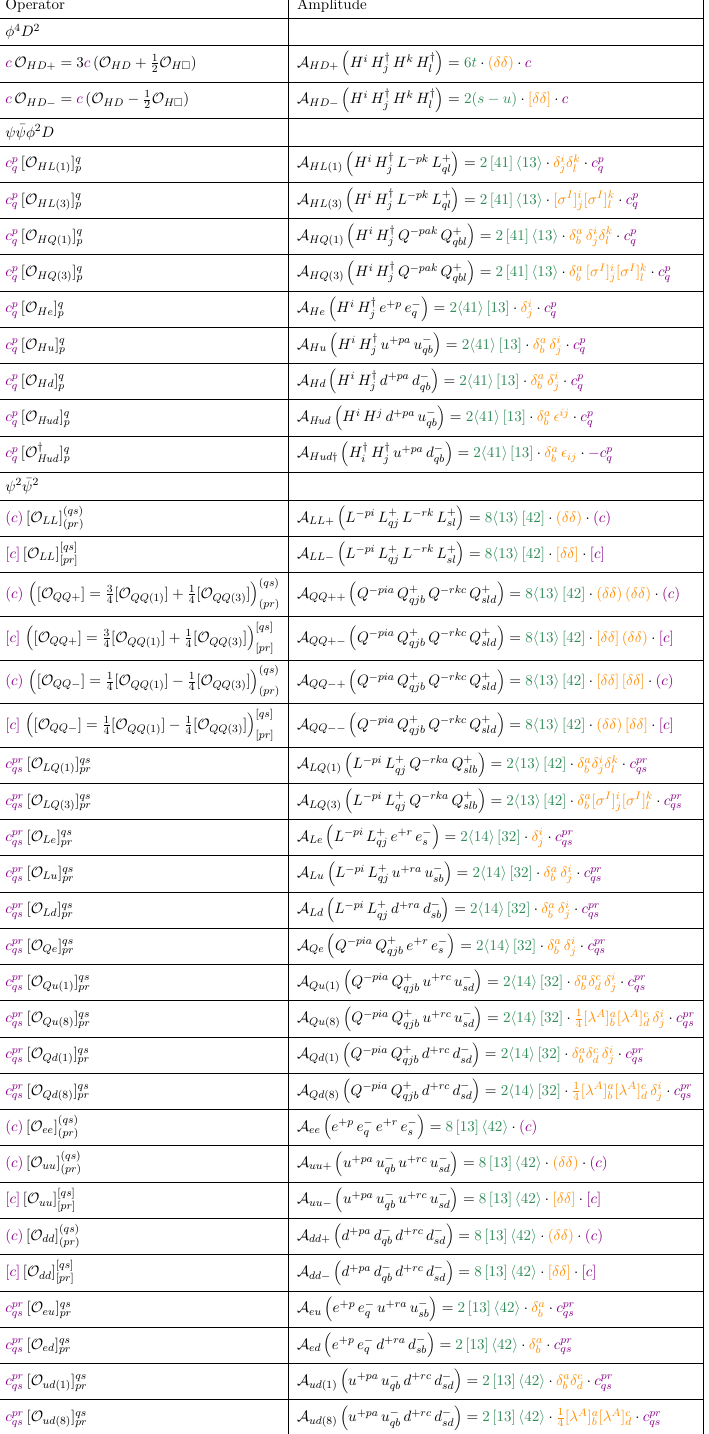
Table 11 . Correspondence between (4 , 0) dimension 6 operators in the Warsaw basis and on-shell amplitudes. We represent in green the kinematic factors, in orange the gauge factors and in purple the flavour factors. The symbols ( δδ ) , ( c ) and [ δδ ] , [ c ] stand for symmetric and antisymmetric indices combinations,